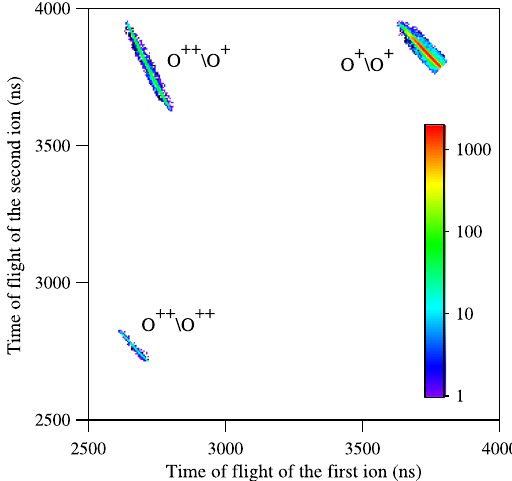
Figure 3. Photoion-photoion coincidence map (PIPICO) represented on a log scale. Three dissociation pathways are identified. The strongest one leads to the formation of the (O + , O + ) pair, while the other two, much weaker, produce (O ++ , O + ) and (O ++ , O ++